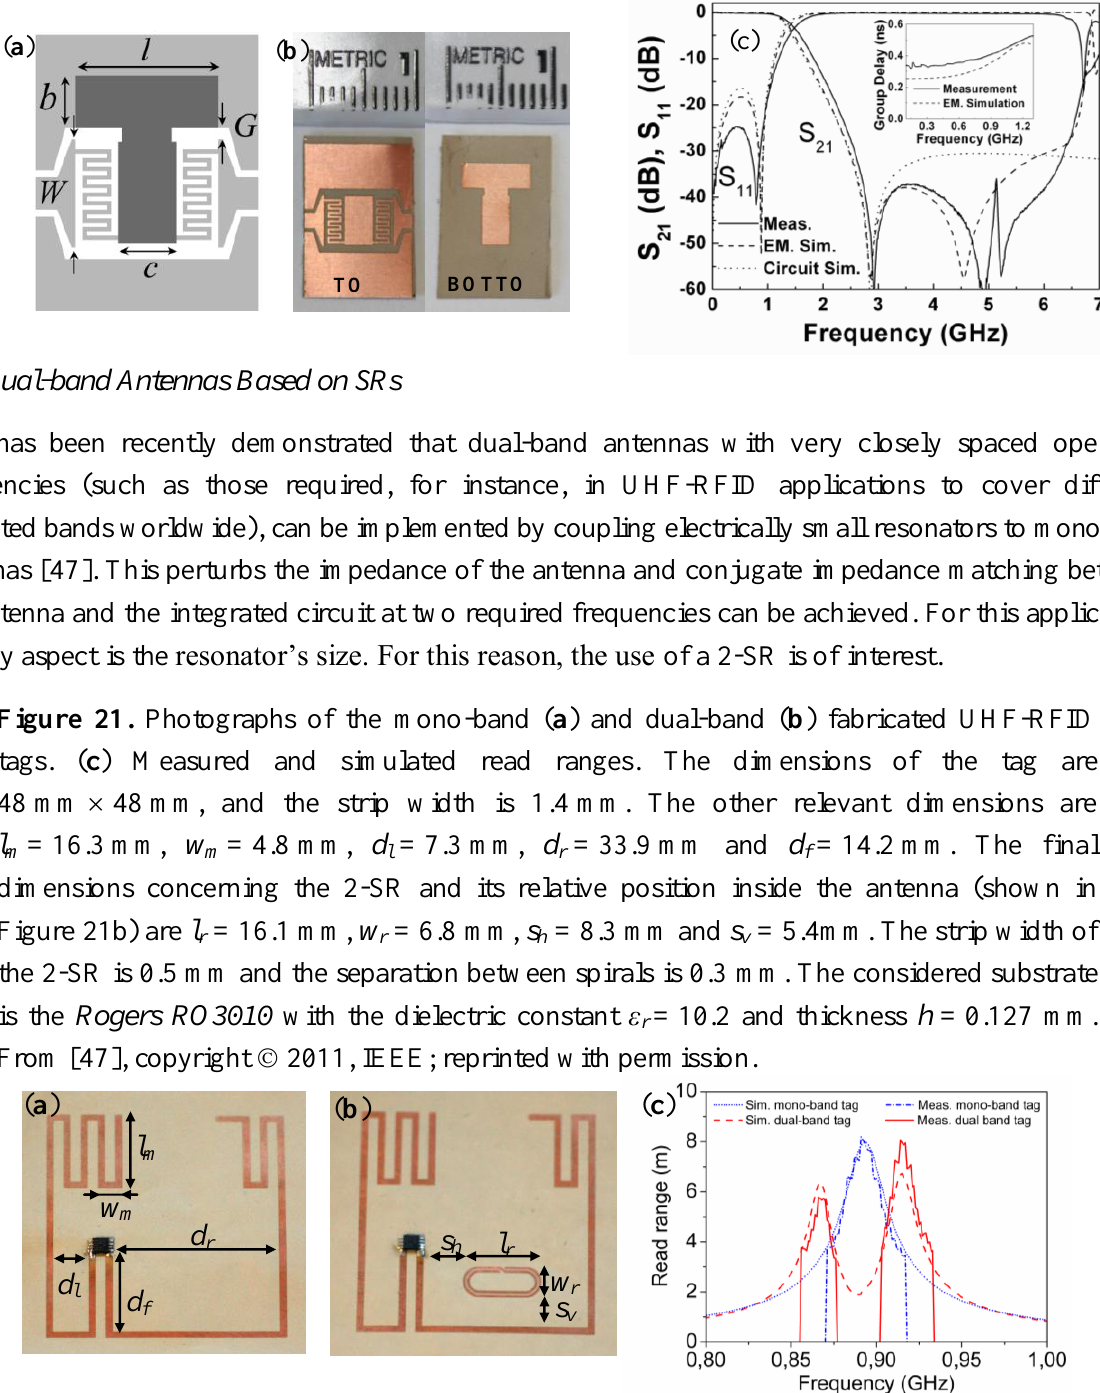
Figure 20. Layout ( a ), photograph ( b ), and frequency response ( c ) of the fabricated elliptic lowpass filter. Dimensions are: W = 5 mm, G = 0.55 mm, l = 6.6 mm, b = 2.42 mm, c = 2.7 mm. The strips of the meander lines are of 0.2 mm. The filter has been fabricated on the Rogers RO3010 substrate with measured dielectric constant  = 11.2 and thickness r h = 254 μm. The circuit simulation corresponds to an ideal elliptic filter with the following characteristics: order-3 elliptic-function LPF with a passband ripple of L = 0.1 dB, Ar a cutoff frequency of f = 1 GHz and a stopband attenuation of L = 30.52 dB with the c As equal-ripple stopband starting normalized frequency Ω = 2.5. From [46], copyright s  2010, IEEE; reprinted with permission.